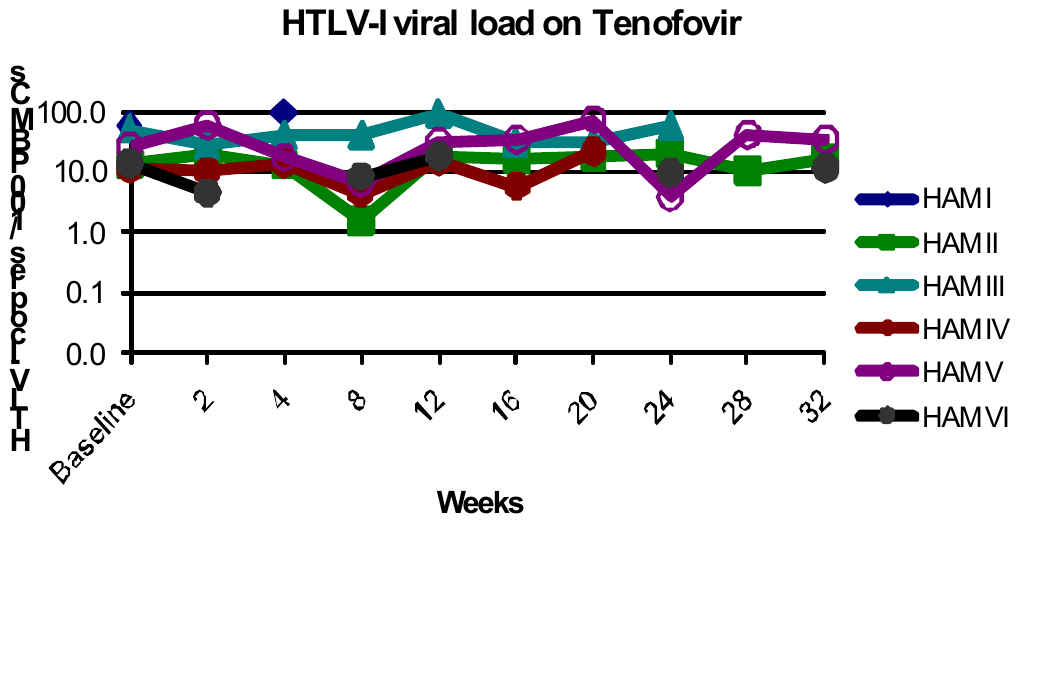
Figure 3. In vivo HTLV-1 viral load (HTLV DNA copies /100 PBMCs) during treatment with